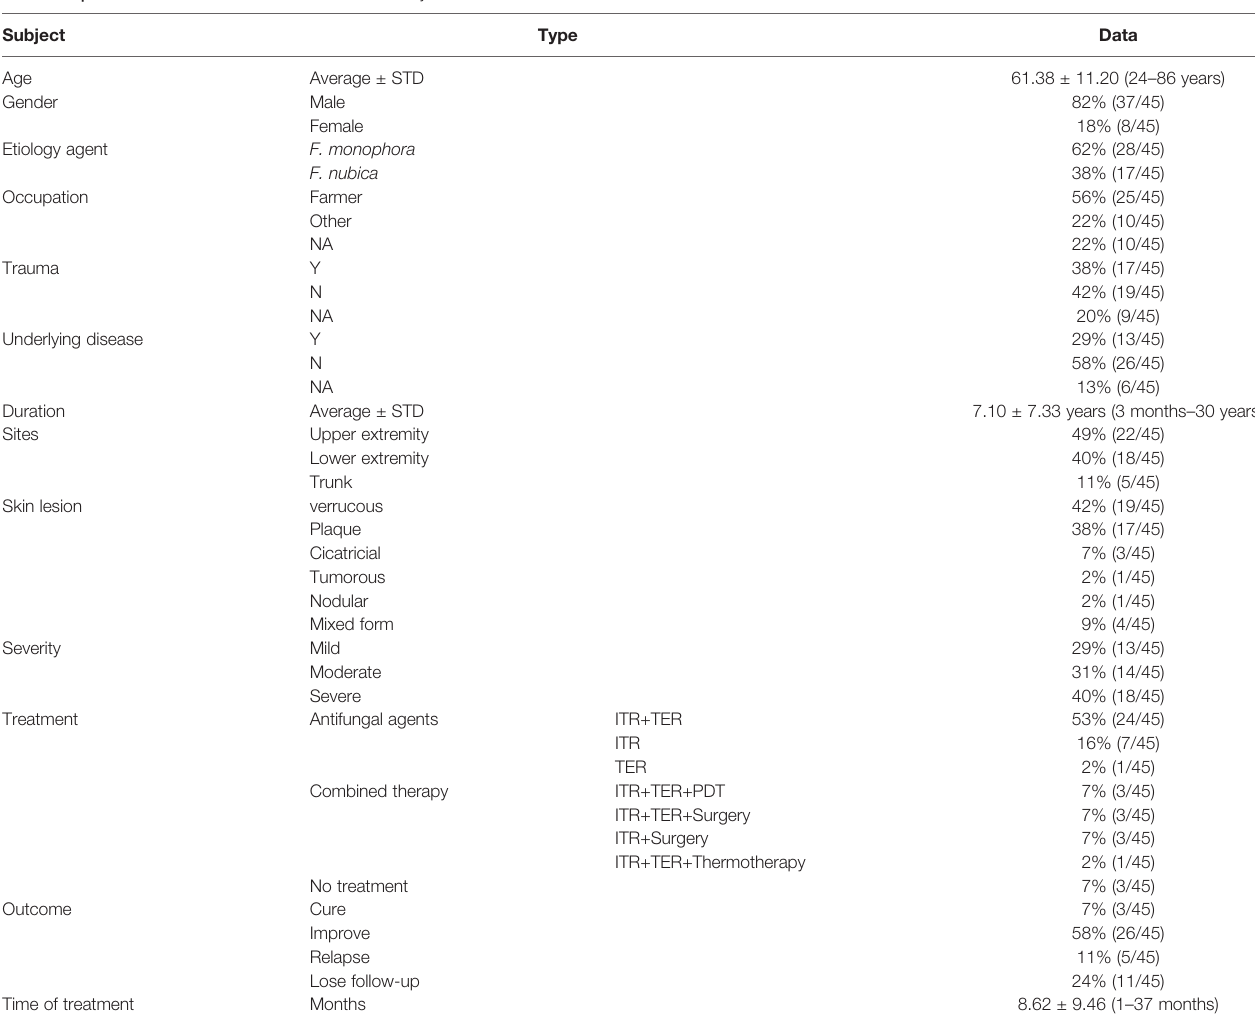
TABLE 1 | Clinical data of 45 cases of